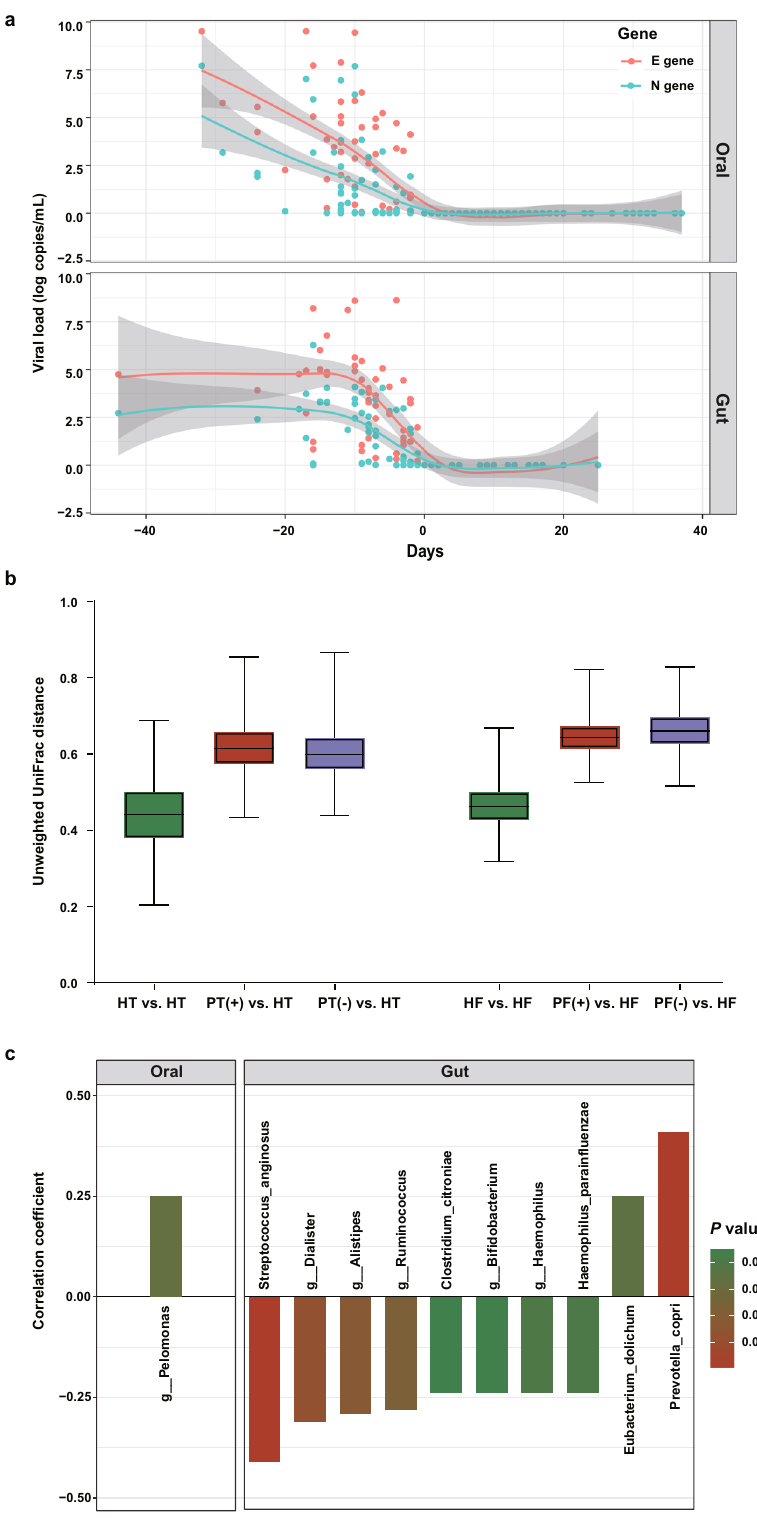
Fig. 4 Associations between oral/gut microbiota disturbance and SARS-CoV-2 viral loads in hospitalized patients. a Longitudinal changes of viral loads in throat swab samples and fecal specimens from COVID-19 patients. Day 0 indicated the negative conversion time of SARS-CoV- 2 RNA. The red line and blue line indicated longitudinal changes in viral loads represented by the abundances of the E gene and N gene, respectively. b Boxplots showing unweighted UniFrac distances within and between groups. c The longitudinal viral load represented by the abundances of the E gene signi fi cantly correlated with the timepoint-matched relative abundances of different taxa in throat swab and fecal samples separately. p -values were obtained using